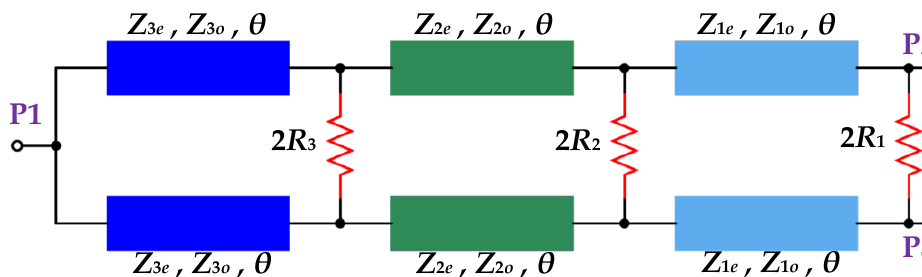
Figure 2 . The tri-section coupled-line WPD Figure 2. The tri-section coupled-line WPD.